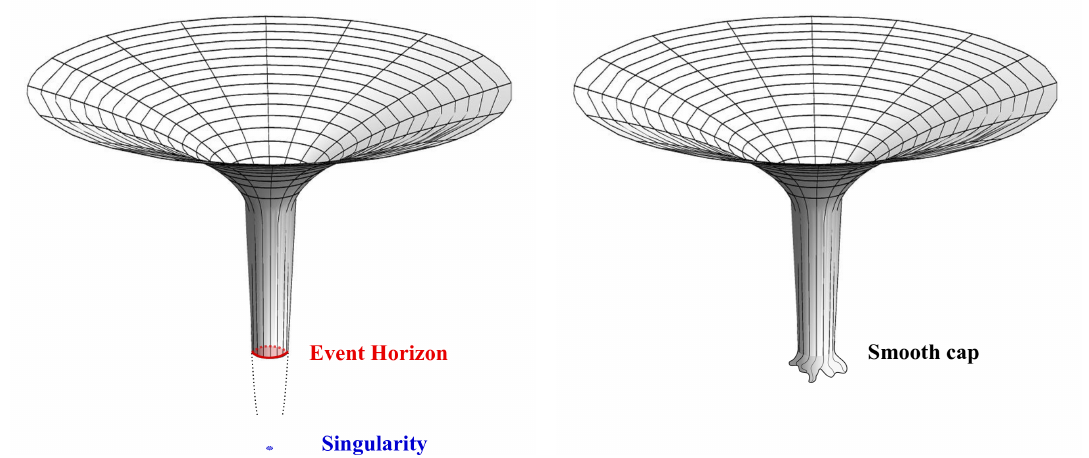
Figure 1 . Schematic picture of a classical black hole (left) and a microstate geometry (right). From the asymptotic observer’s point of view, instead of the event horizon lying at the bottom of a throat of infinite length, a microstate geometry would replace it with a smooth cap lying at the bottom of a throat of finite length. In the scaling limit, its throat length increases to infinity while the cap’s geometry stays constant. The figures are from